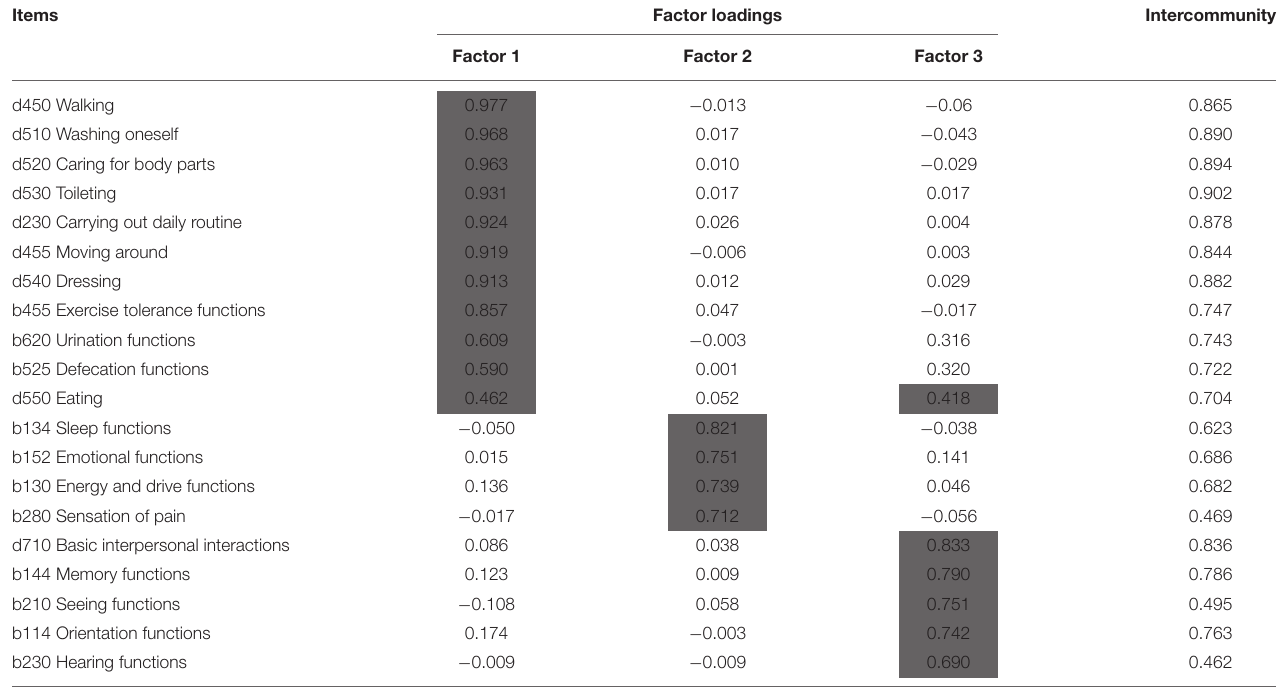
TABLE 4 | Factors, items and factor loadings of disability assessing tool based on ICF ( n = 1,610).